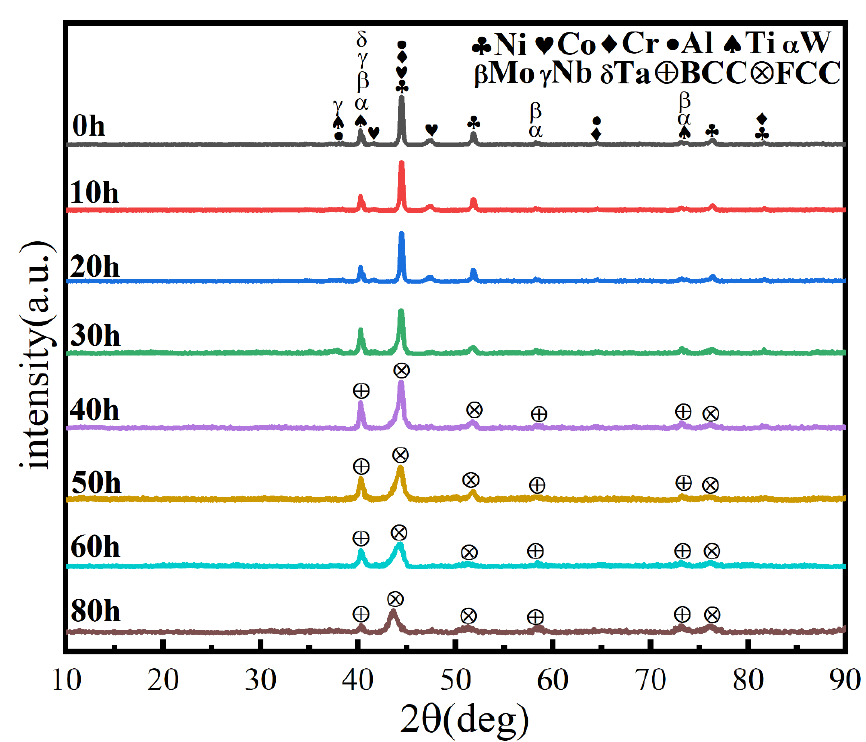
Figure 6. XRD patterns of powders at different milling times at a milling speed of 500 r min − 1 and with stearic acid as PCA.